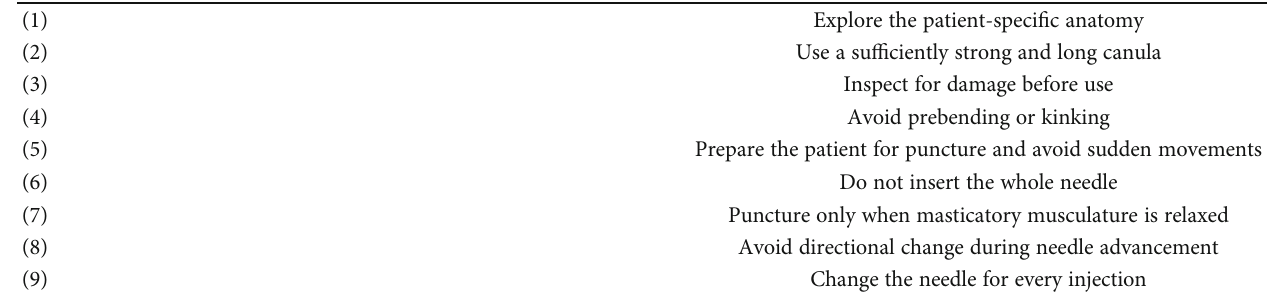
Figure 4: Suggestion for treatment during pandemic crises such as COVID-19. Dislocated fractured needle movement usually requires treatment in a department for maxillofacial surgery. Table 1: Eight crucial points for avoiding needle breakage